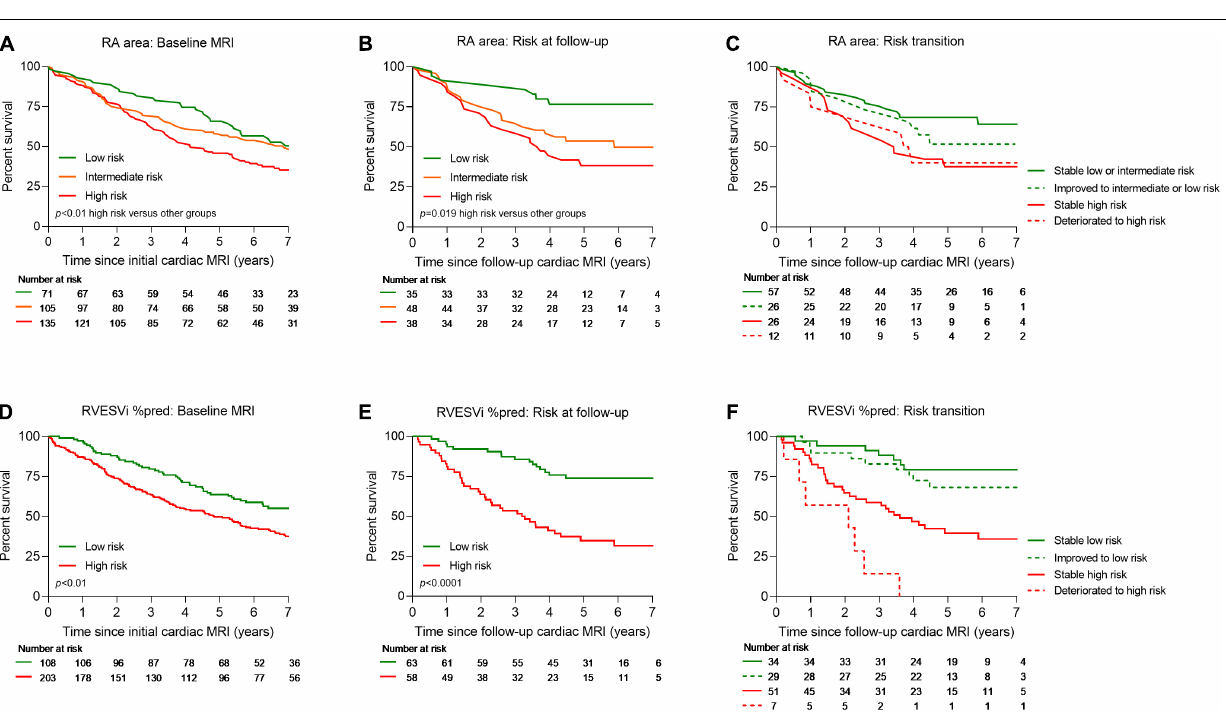
FIGURE 2 | Kaplan–Meier survival curves for treatment naïve patients for RA area at baseline (A) , RA area at follow-up cardiac MRI (B) , transition of risk between baseline and follow-up cardiac MRI for RA area (C) , RVESVi %pred at baseline (D) , RVESVi %pred at follow-up cardiac MRI (E) , and transition of risk between baseline and follow-up cardiac MRI for RVESVi %pred (F) . MRI, magnetic resonance imaging; RA, right atrial; %pred, percentage predicted for age and sex; RVESVi, right ventricular end-systolic volume